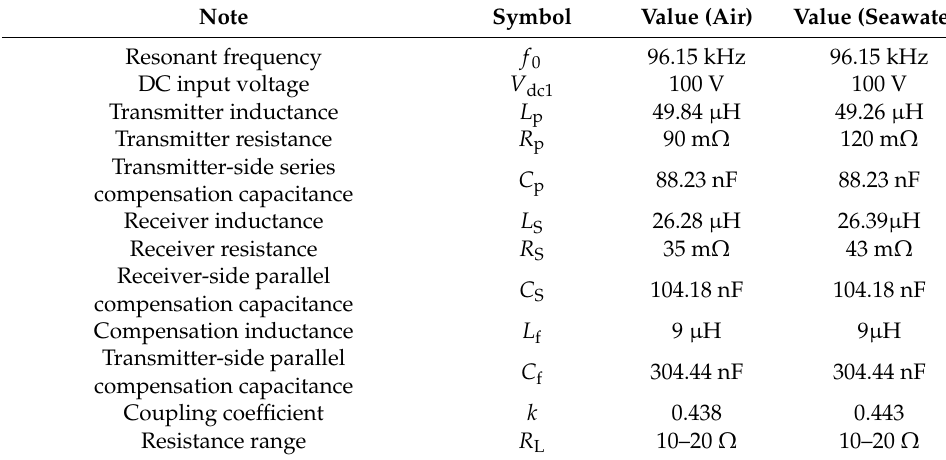
Table 3. System Table 3. System Parameters.